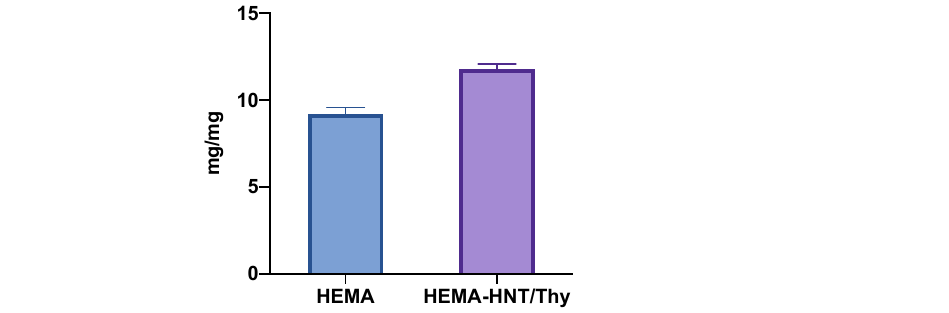
Figure 3. FTIR spectra of ( a ) HEMA and HEMA-HNT/Thy; ( b ) HEMA-HNT; ( c ) Thy; ( d ) HEMA- HNT/Thy with HEMA-HNT subtraction.